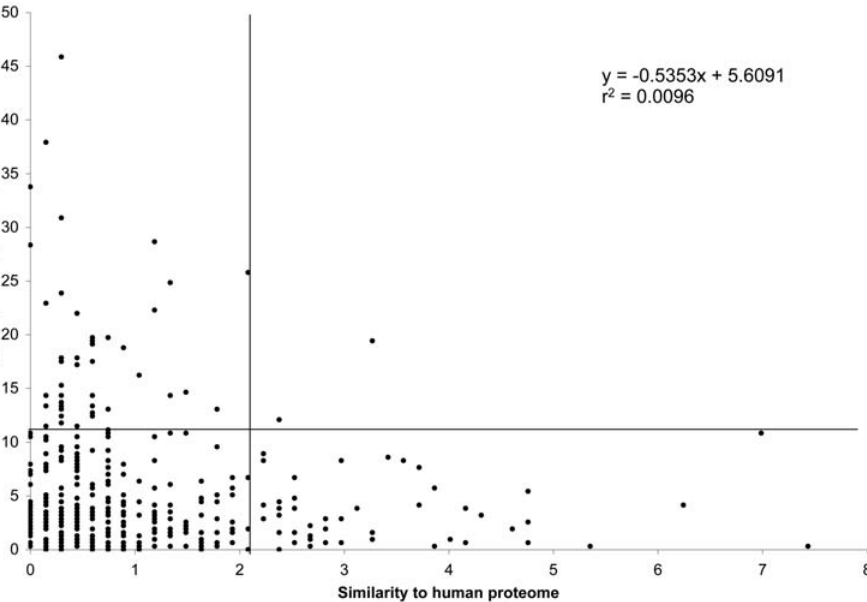
Figure 1. Frequency of recognition of HIV-1 B consensus 2001 peptides as a function of their similarity to human proteins. 410 peptides spanning the HIV-1 B consensus 2001 proteome were tested by ELISpot using PBMC from a cohort of 314 HIV-1 infected individuals. The vertical axis corresponds to the percentage of individuals who recognized a given peptide. The horizontal axis corresponds to the number of matches to the human proteome for each peptide. Matches were derived by dissecting the 410 peptides into overlapping 6-mers offset by one residue, and then scored against the RefSeq protein sequence database. Matches were normalized to account for the length of the starting peptide (ranging from 15–20 AA in length).